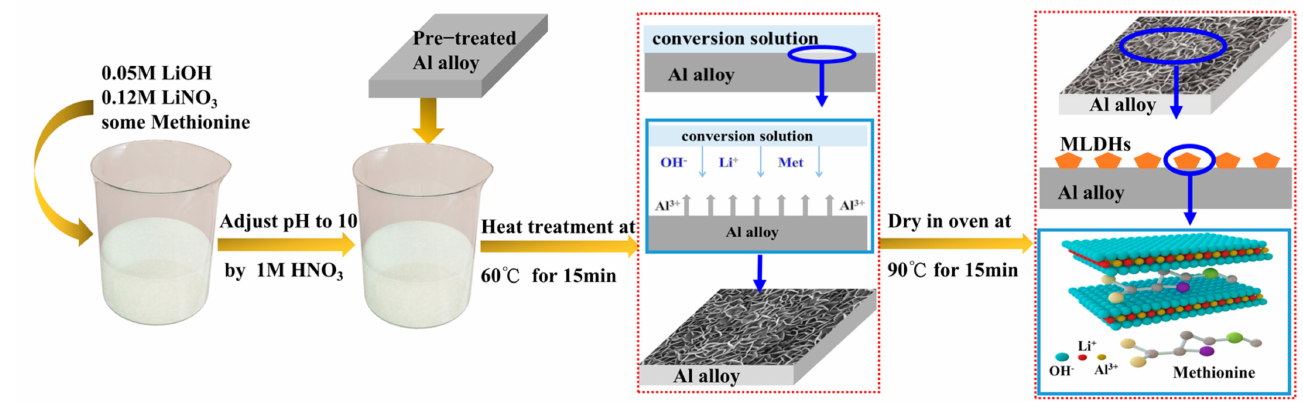
Figure 1. Schematic illustration for preparation of